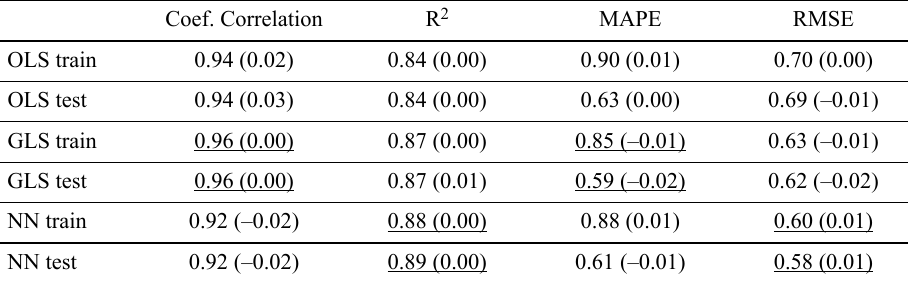
Table 3. Results for extended subjective MCI